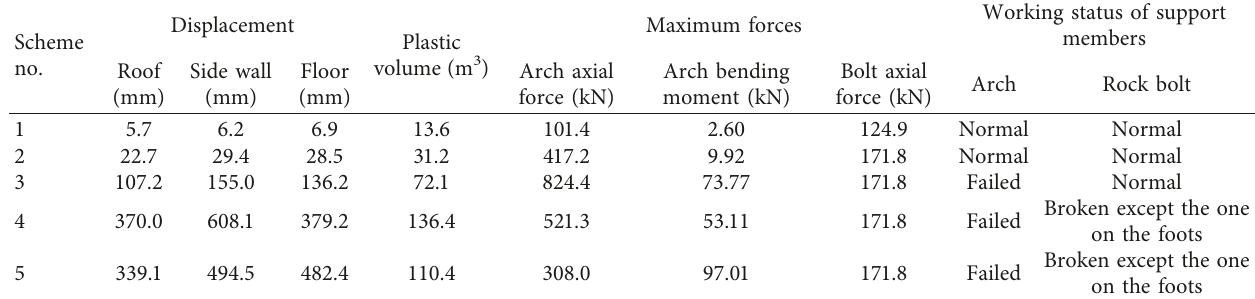
Table 4: Main results of schemes 1–5 (time 50